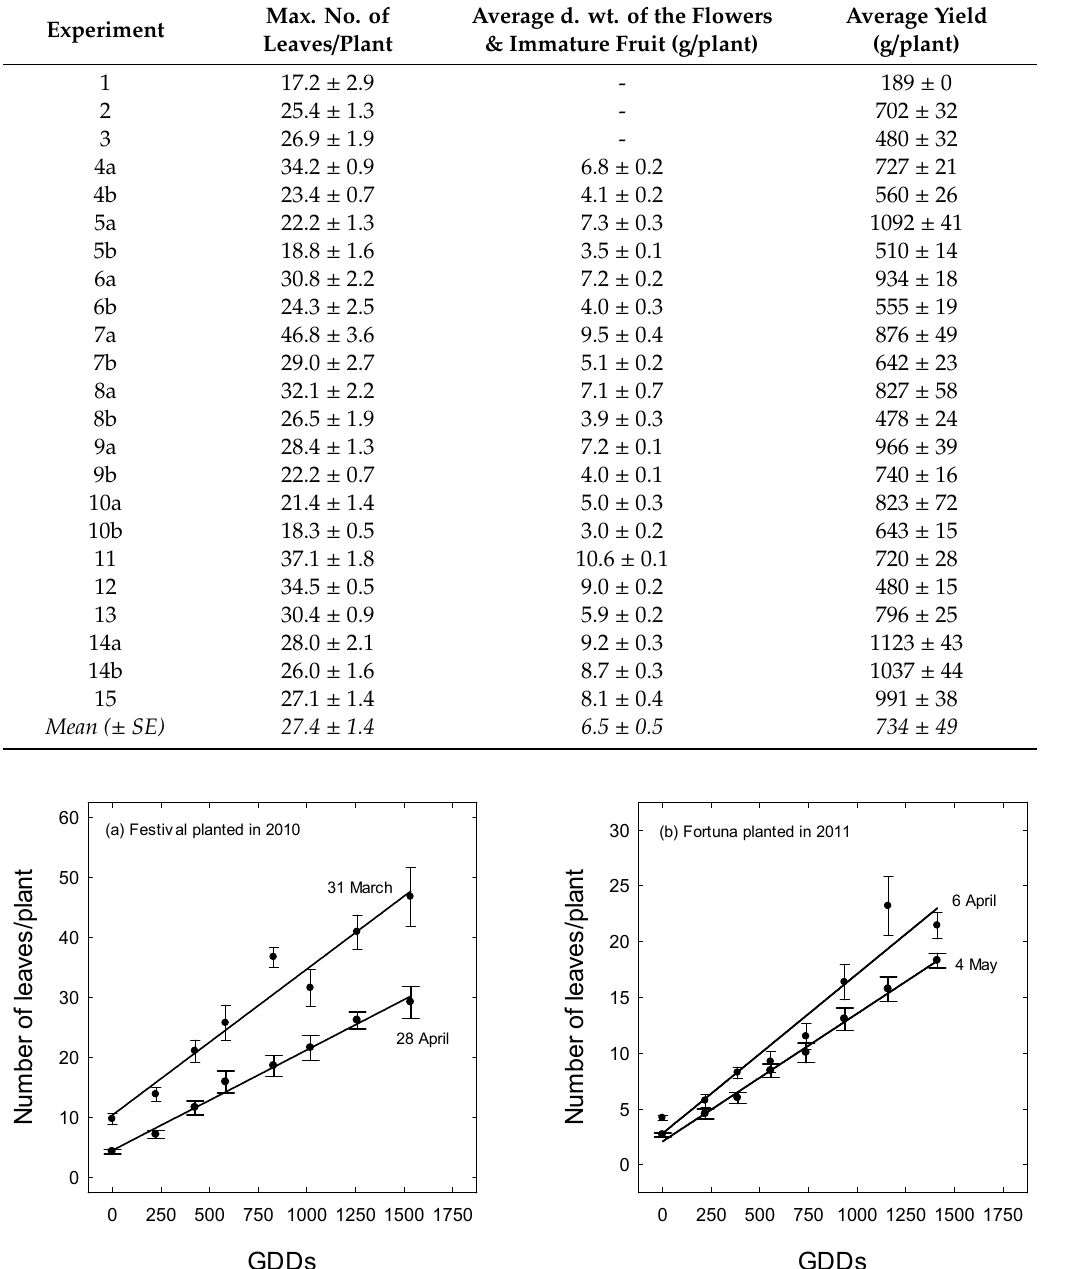
Table 4. Mean maximum number of leaves, average dry weight of the flowers and immature fruit, and yield in the di ff erent experiments with the strawberries in Queensland. Data are presented with standard errors (SEs). Details of the experiments are provided in Tables 1 and 2.